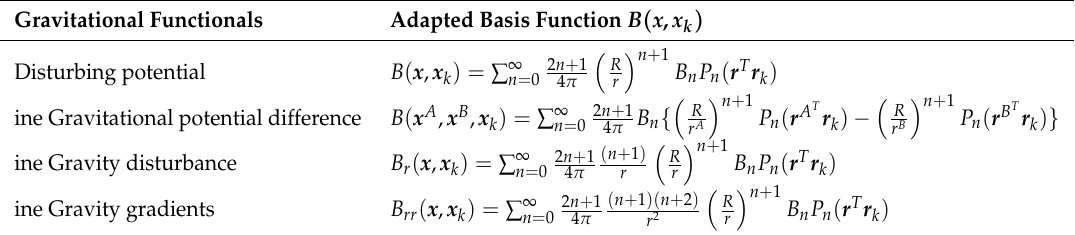
Table 1. Kernels, i.e., the adapted basis functions for different gravitational